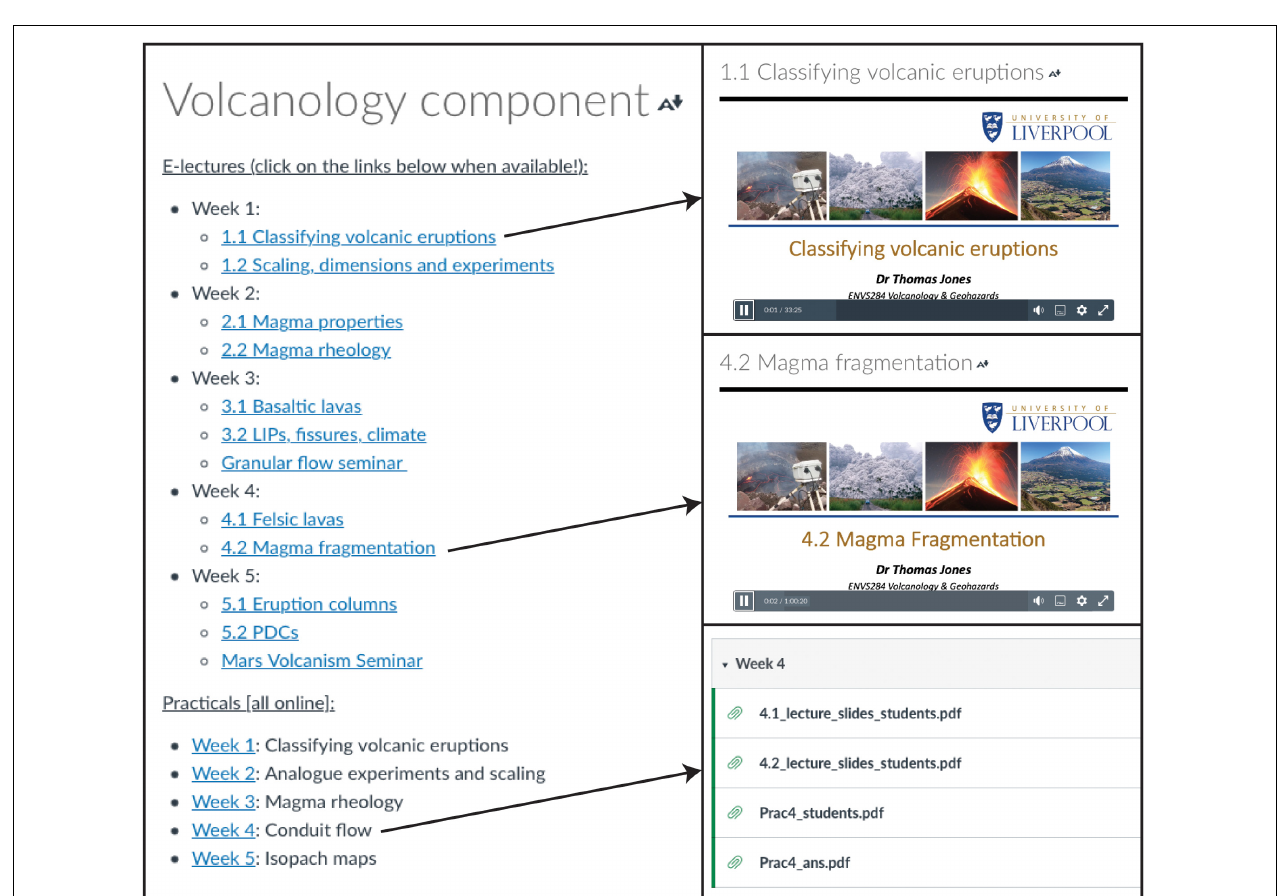
FIGURE 1 | Screenshots of the VLE layout. The volcanology component home page is shown on the left. From this home page all the asynchronous teaching material can be accessed. The numbered lectures link to a page with the pre-recorded lecture video embedded. The hyperlinked week numbers (e.g., “Week 1”) listed at the bottom of the home page link to a file collection containing the pdf lecture slides, question sheets for the practical sessions and answers. Representative links are shown by the